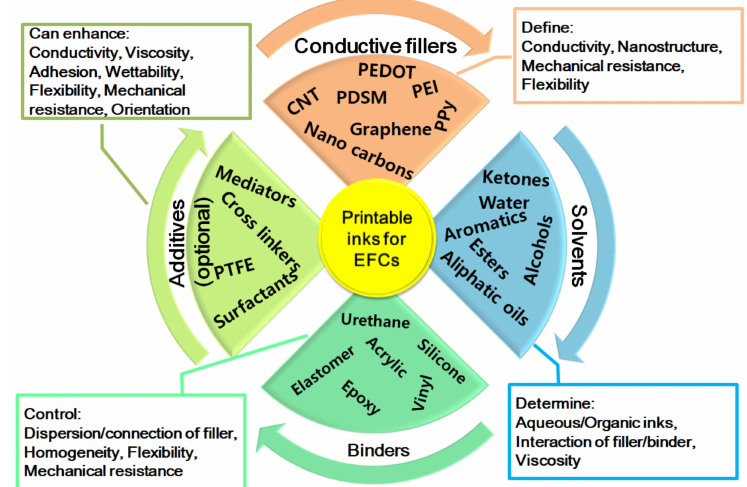
Figure 9. The four components for the advanced formulation of printable inks as the main soft material for wearable EFCs. The role and specific properties a ff ected by each component are